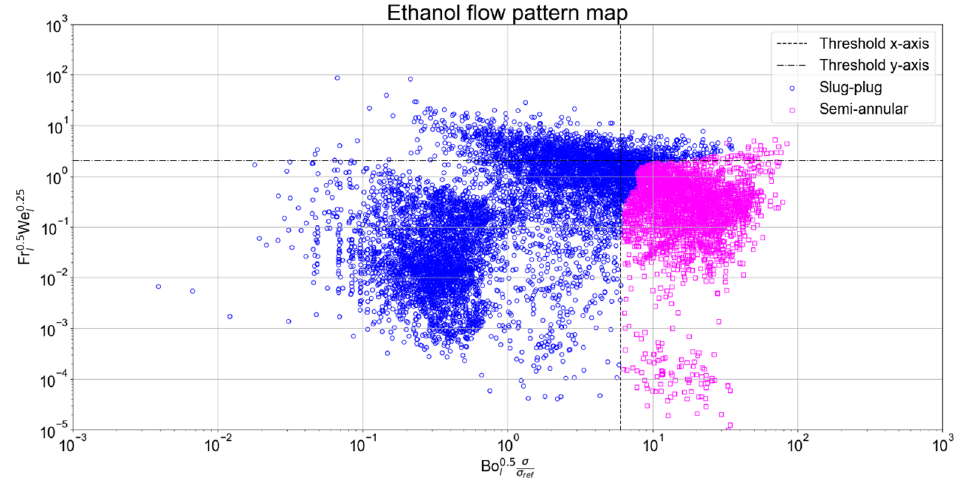
Figure 9. Updated flow pattern map for ethanol: multilayer perceptron.